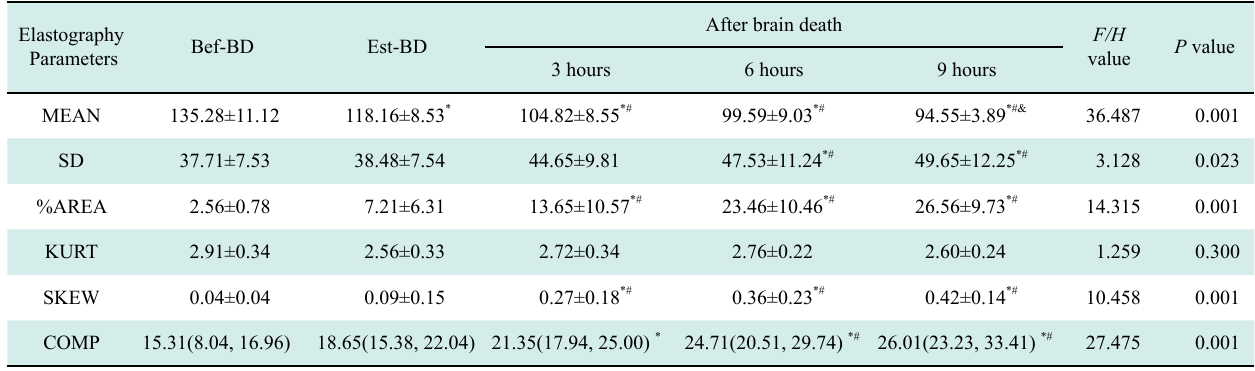
Table 5 Elastography parameters evaluated changes at Bef-BD, Est-BD, and 3, 6, and 9 hours after brain death. Elastography Parameters